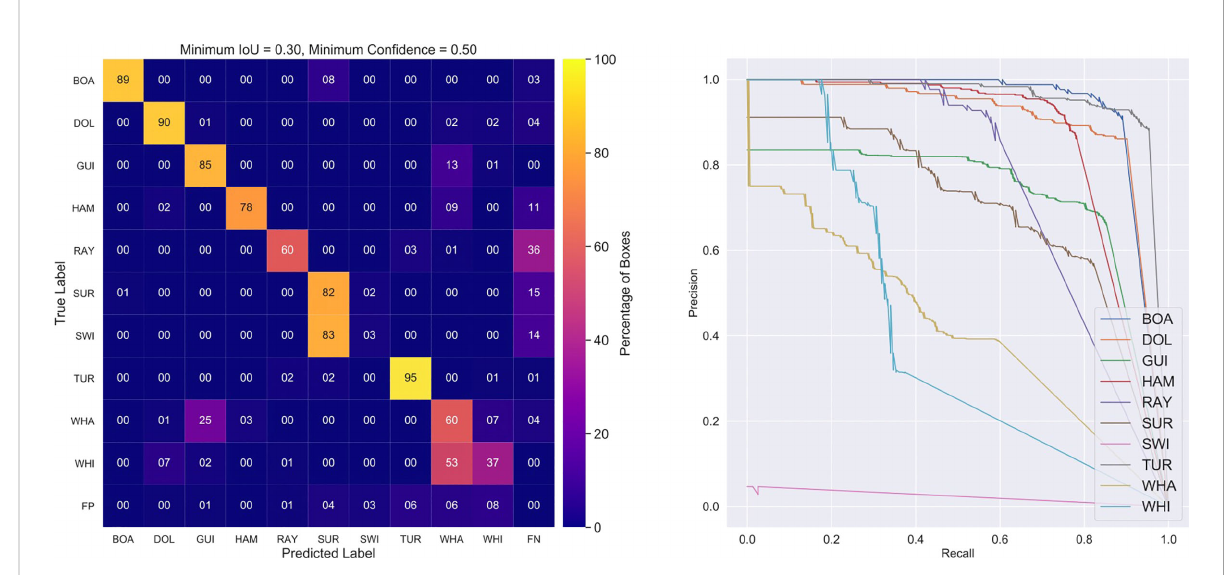
FIGURE 11 Confusion matrix (left) and precision-recall plot (right) for the fi nal MobileNet V1 model applied to the external testing dataset. As expected, the measured performance is worse than on the internal dataset (see Figure 10), but still respectable, with a mAP = 0.60. Most of the same patterns are visible in the confusion matrix compared to ResNet 50 (see Figure 9), except that MobileNet V1 does less well on smaller objects (e.g., rays). Interestingly, guitar fi sh and hammerheads are more reliably identi fi ed compared to ResNet50, but this may re fl ect the longer (and slower) training regime required for the Mobilenet V1 to converge